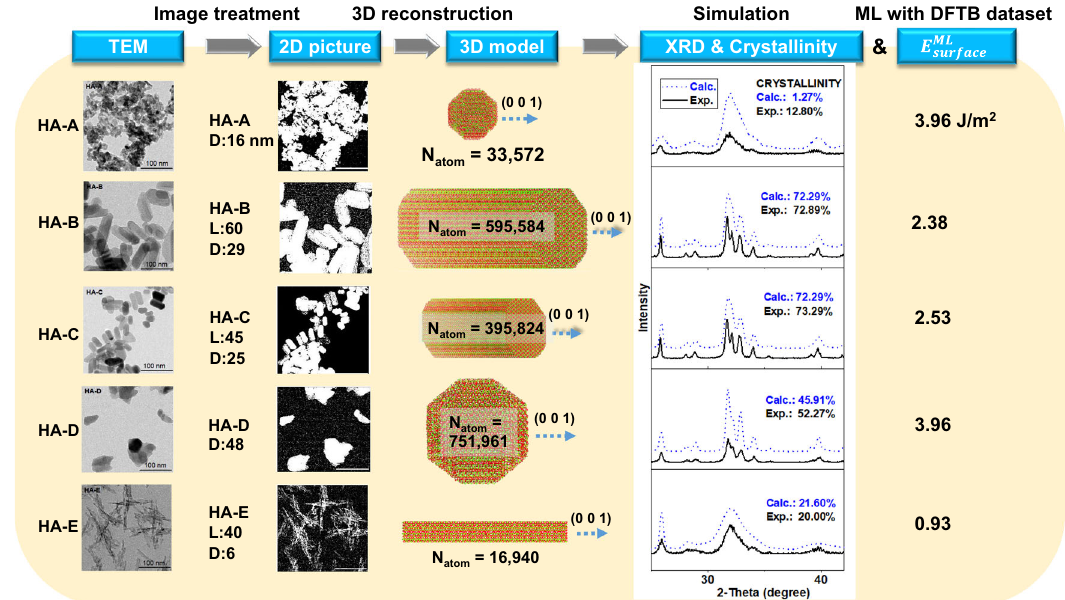
Fig. 7 XRD simulations with the TEM-derived structures. Flowchart for XRD simulations: the image segmentation of TEM image, giving rise to 2D information. Then 3D models were built from geometry parameters such as L and D . Simulations of XRD and crystallinity are obtained from these 3D models. The surface energies are also predicted by LightGBM trained on DFTB